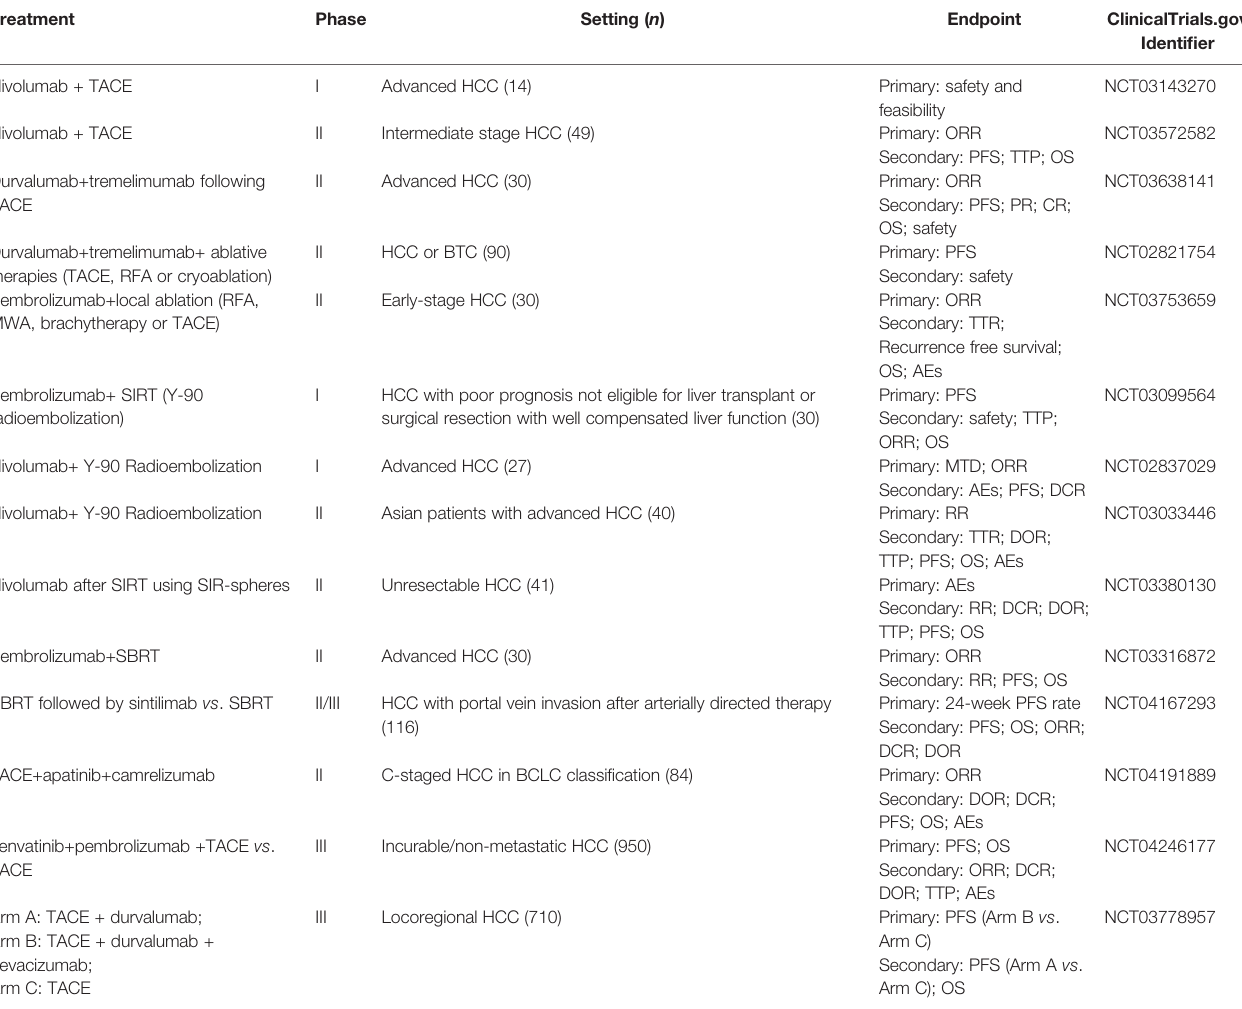
TABLE 5 | Ongoing clinical trials combining immunotherapy and locoregional therapy in HCC.